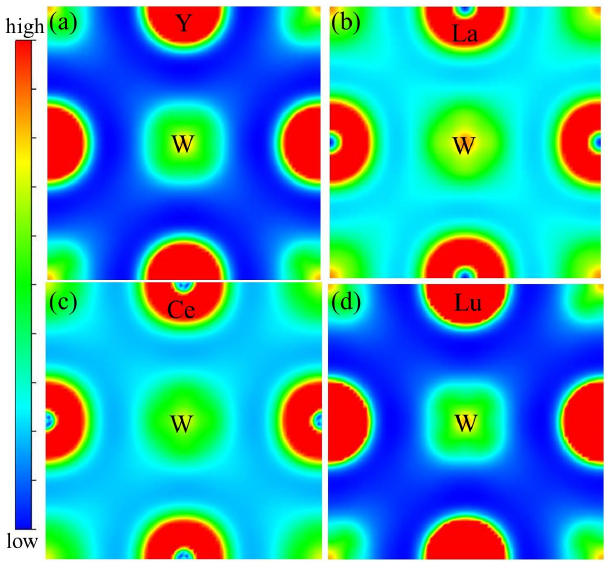
Figure 8. Charge density distribution for rare earth atoms incorporated in W. The ( a – d ) corresponds to Y, La, Ce and Lu located at the substitutional site.